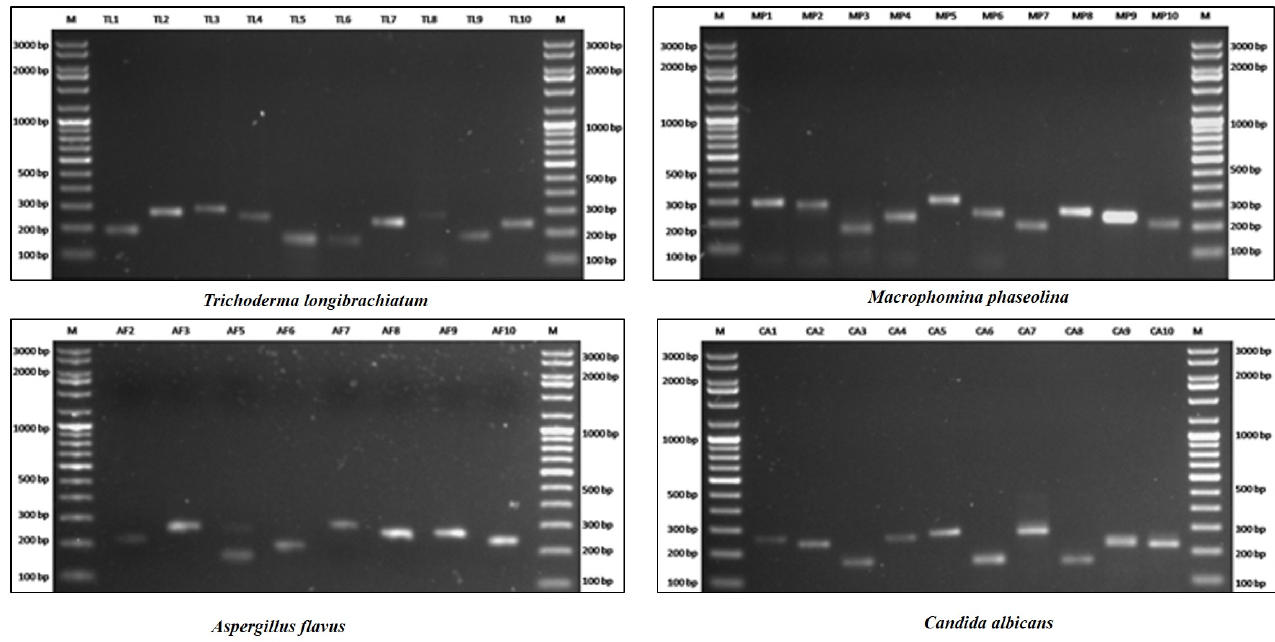
Figure 6. In vitro PCR genotyping evaluation of SSRs from